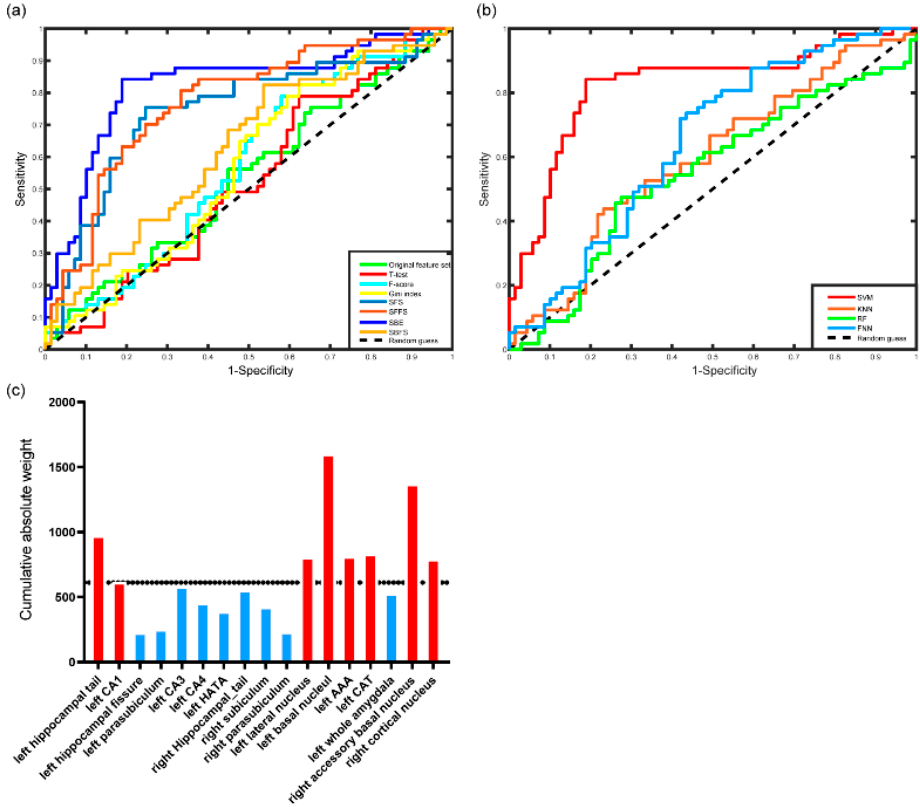
Figure 3. Results of SVM classification: ( a ) receiver operating characteristic (ROC) curves of the linear SVM classifier with the original feature set and 7 different feature selection approaches, ( b ) ROC curves of 4 classifiers, and ( c ) the features selected by sequential backward elimination (SBE) approach and their cumulative absolute weights. The regions with red color represent the 8 regions having top cumulative absolute weights.